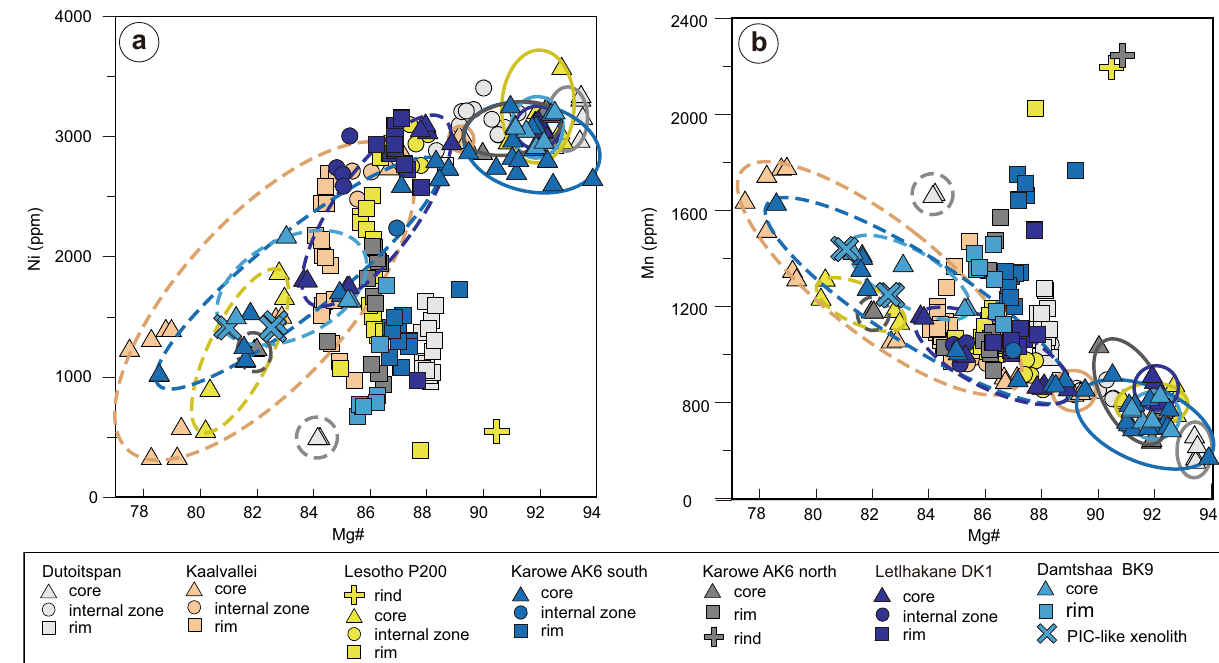
Fig. 2 Mg#-Ni-Mn covariations diagrams for olivine grains. Mg# versus ( a ) Ni and ( b ) Mn in olivine from the examined southern African kimberlites. Solid lines mark out high-Mg olivine cores, and dashed lines the low-Mg olivine